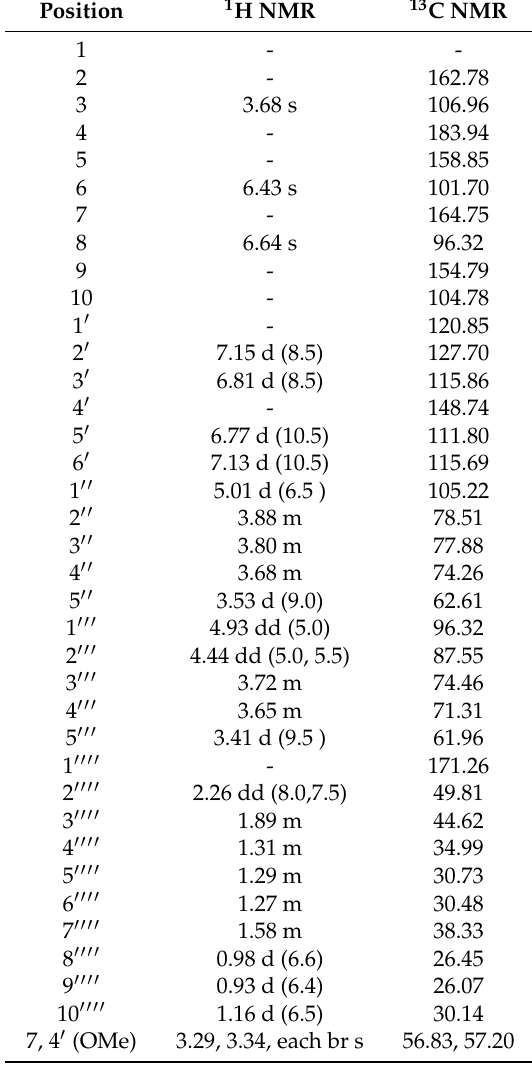
Table 2. 1 H NMR and 13 C NMR Spectroscopic data of compound 2.